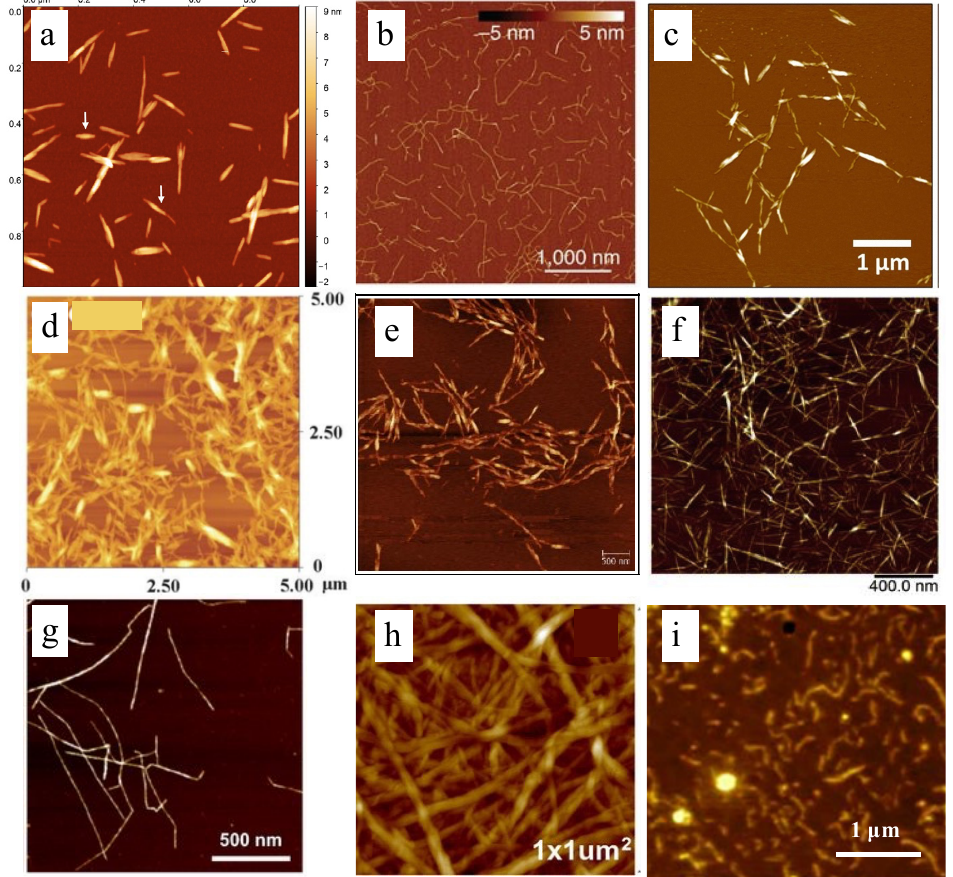
Figure 5. Nanocellulose prepared from different methods: ( a ) H 2 SO 4 , reprinted with permission from [81], 2021, Springer; ( b ) TEMPO, reprinted with permission from [82], 2015, nature; ( c ) H 3 PO 4 , reprinted with permission from [83], 2019, Springer; ( d ) HCl, reprinted with permission from [84], 2013, RSC; ( e ) maleic acid, reprinted with permission from [85], 2017, Wiley; ( f ) oxalic acid, reprinted with permission from [86], 2019, Elsevier; ( g ) TEMPO ‐ oxidized CNF, reprinted with permission from [87], 2021, Springer; ( h ) enzymatic hydrolysis, reprinted with permission from [88], 2017, Springer. ( i ) carboxymethylation, reprinted with permission from [71], 2022, Elsevier .